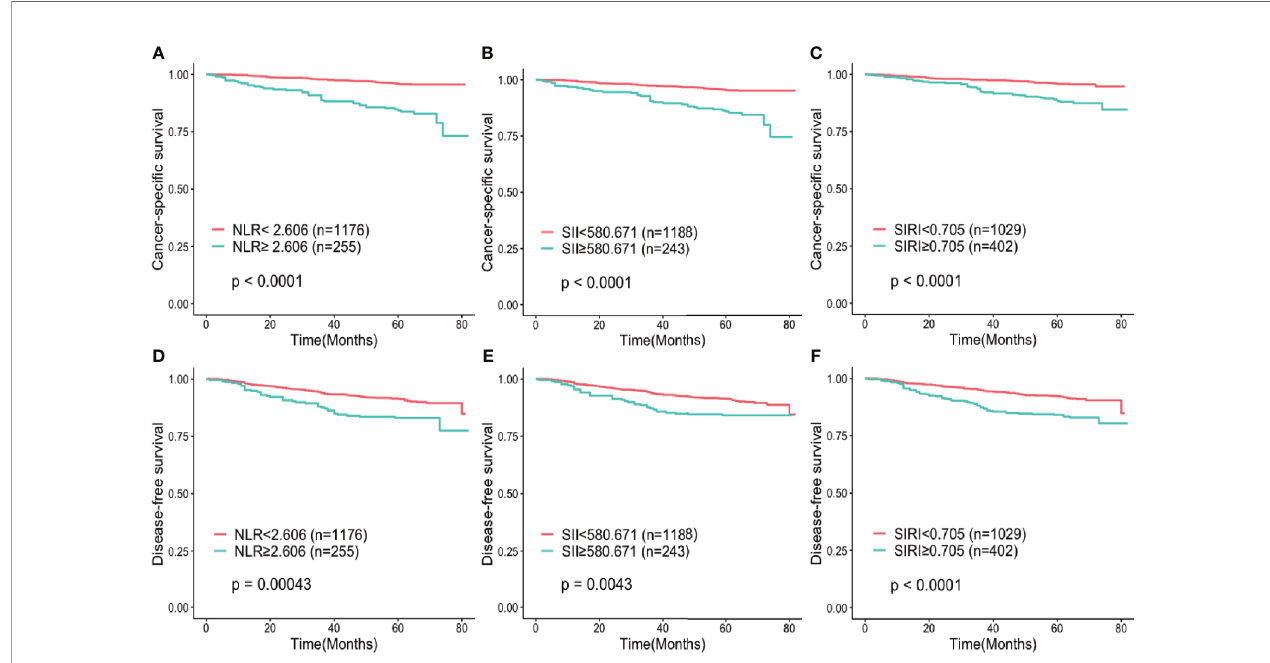
FIGURE 1 | Kaplan – Meier curves for (A – C) cancer-speci fi c survival and (D – F) disease-free survival according to NLR, SIRI and SII. (A, D) Patients were strati fi ed by NLR group; (B, E) Patients were strati fi ed by SII group; (C, F) Patients were strati fi ed by SIRI group. NLR, neutrophil-to-lymphocyte ratio; SII, systemic immune- in fl ammation index; SIRI, systemic in fl ammation response